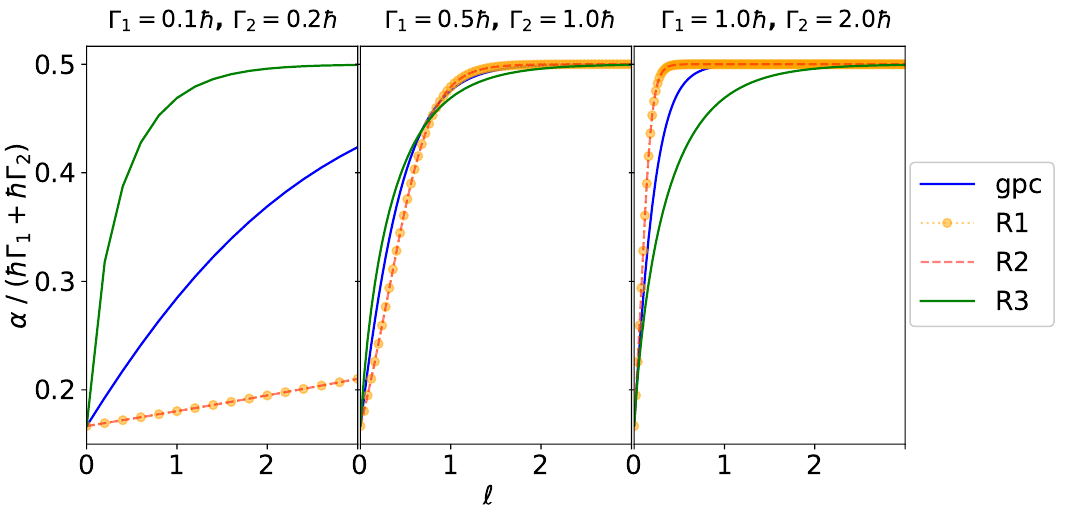
Figure 1: Exemplary flows α ( ℓ ) of the analytical example discussed in Sec.